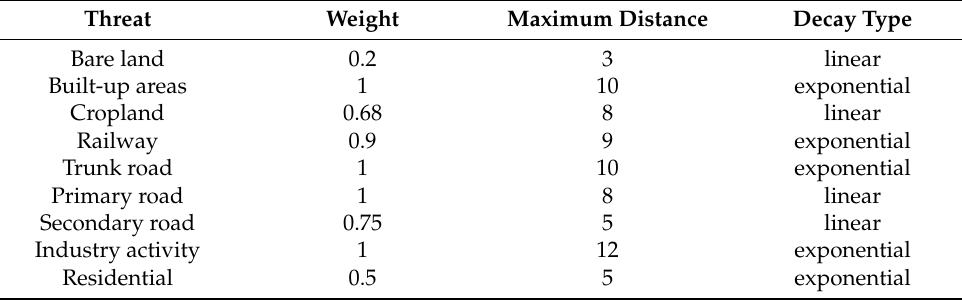
Table 3. Threat factor parameter